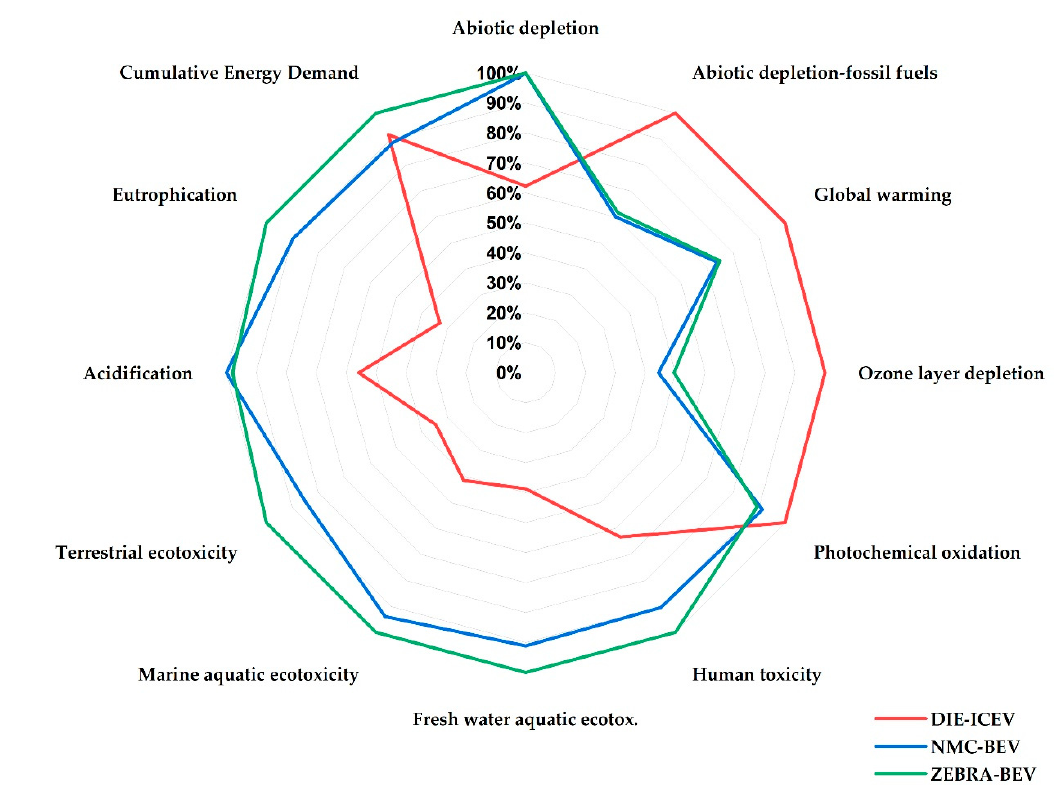
Figure 9. Comparison of the impact categories for NMC111-BEV with an additional battery pack, ZEBRA-BEV and DIE-ICEV. The impacts were normalised to the highest score in each category.